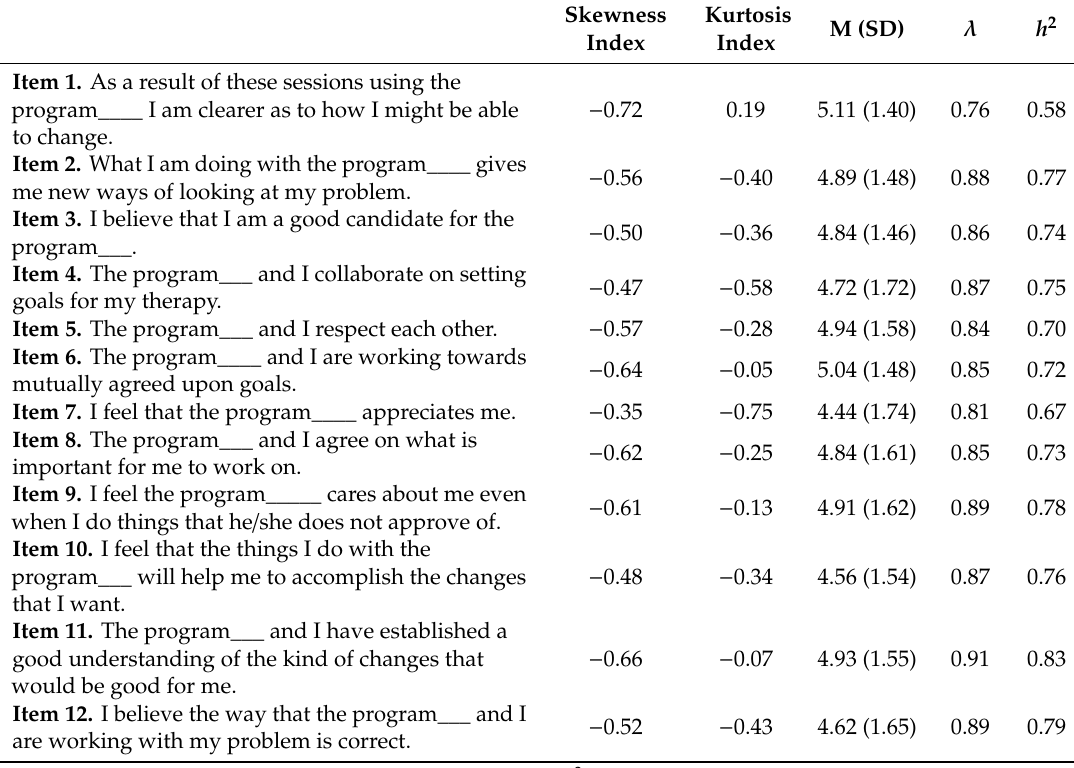
Table 2. Psychometric properties of the WAI-TECH: Descriptive statistics and factorial loadings with a one-factor structure using Maximum